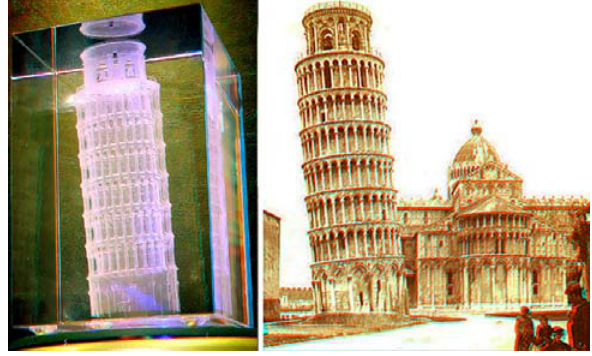
Figure 3. Color anaglyphs of an “early bird” lasered crystal of the famous Leaning Tower of Pisa (Italy) (left; courtesy R.Titze of LOOXIS, Hannover) in comparison with a historic 3D photography (photographs by W. Schuhr)